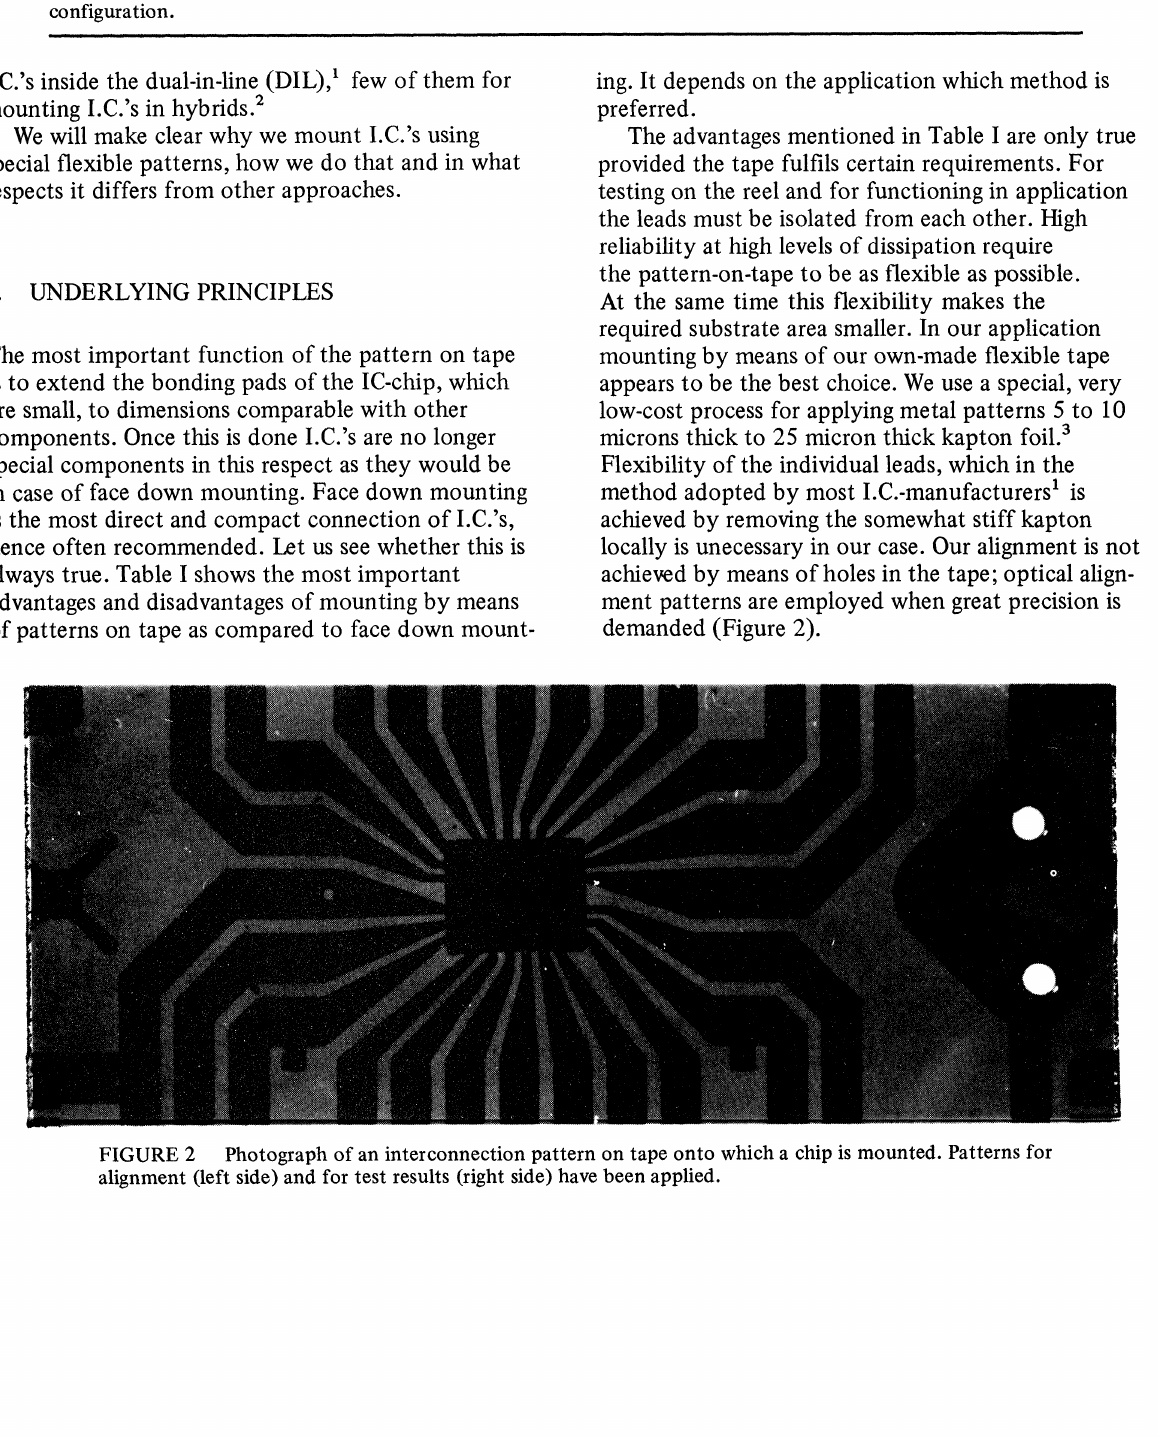
Photograph of an interconnection pattern on tape onto which a chip is mounted. Patterns for alignment (left side) and for test results (right side) have been